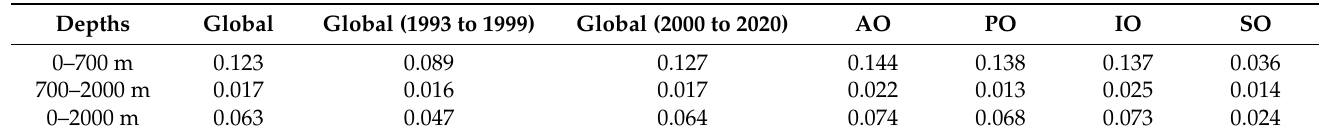
Figure 13. Monthly STA time series in the upper 2000 m of the global ocean from the DORS and IAP datasets from 1993 to 2020. The baseline is from 1993 to 2012. Unit: °C. The lines in the figure were smoothed by running a mean filter for 12 months. Table 3. Warming rates of the global ocean ST at different layers and ocean basins from 1993–2020 in × ◦